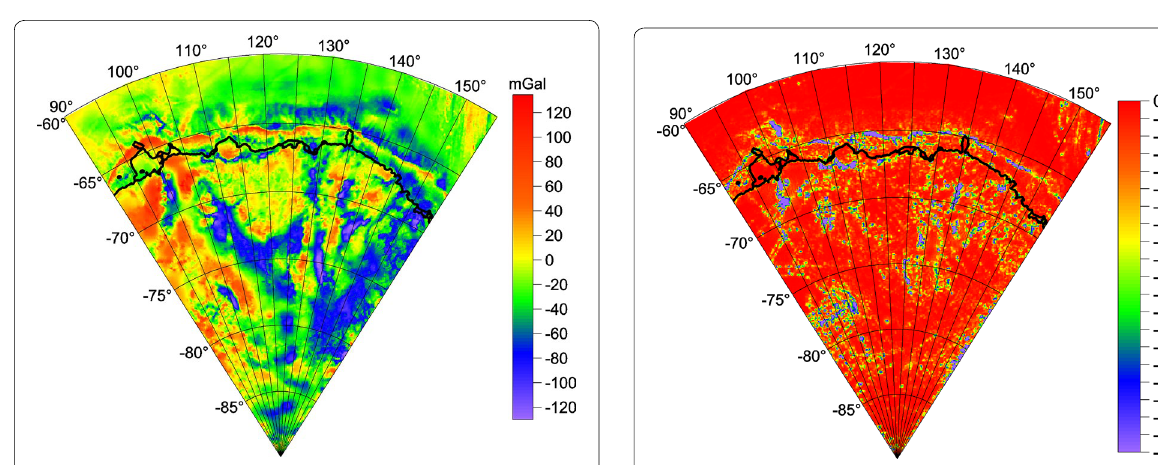
Fig. 6 Δ g [mGal] in the Wilkes Land anomaly area, using the RET 14 model